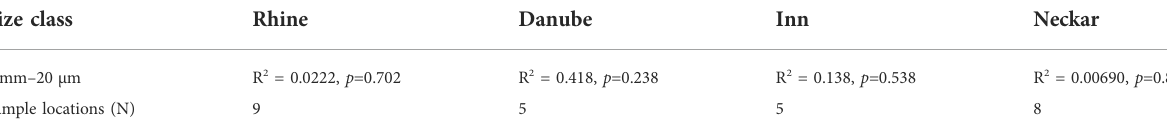
TABLE 1 Statistical results of the linear regression performed using the R-based software Jamovi version 2.2.3 (R package 4.0) to analyze a potential increase of microplastic abundance in the course of the studied rivers with fi ve to nine consecutive samples (Rhine, Neckar, Inn, and Danube) for the size class MP (5 mm – 20